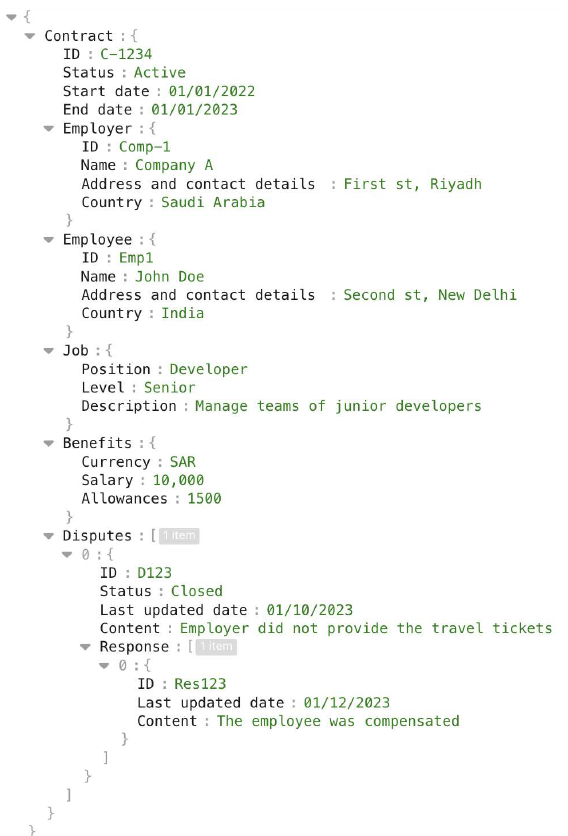
Figure 1. A JSON object representing the employment contract digitally in the smart